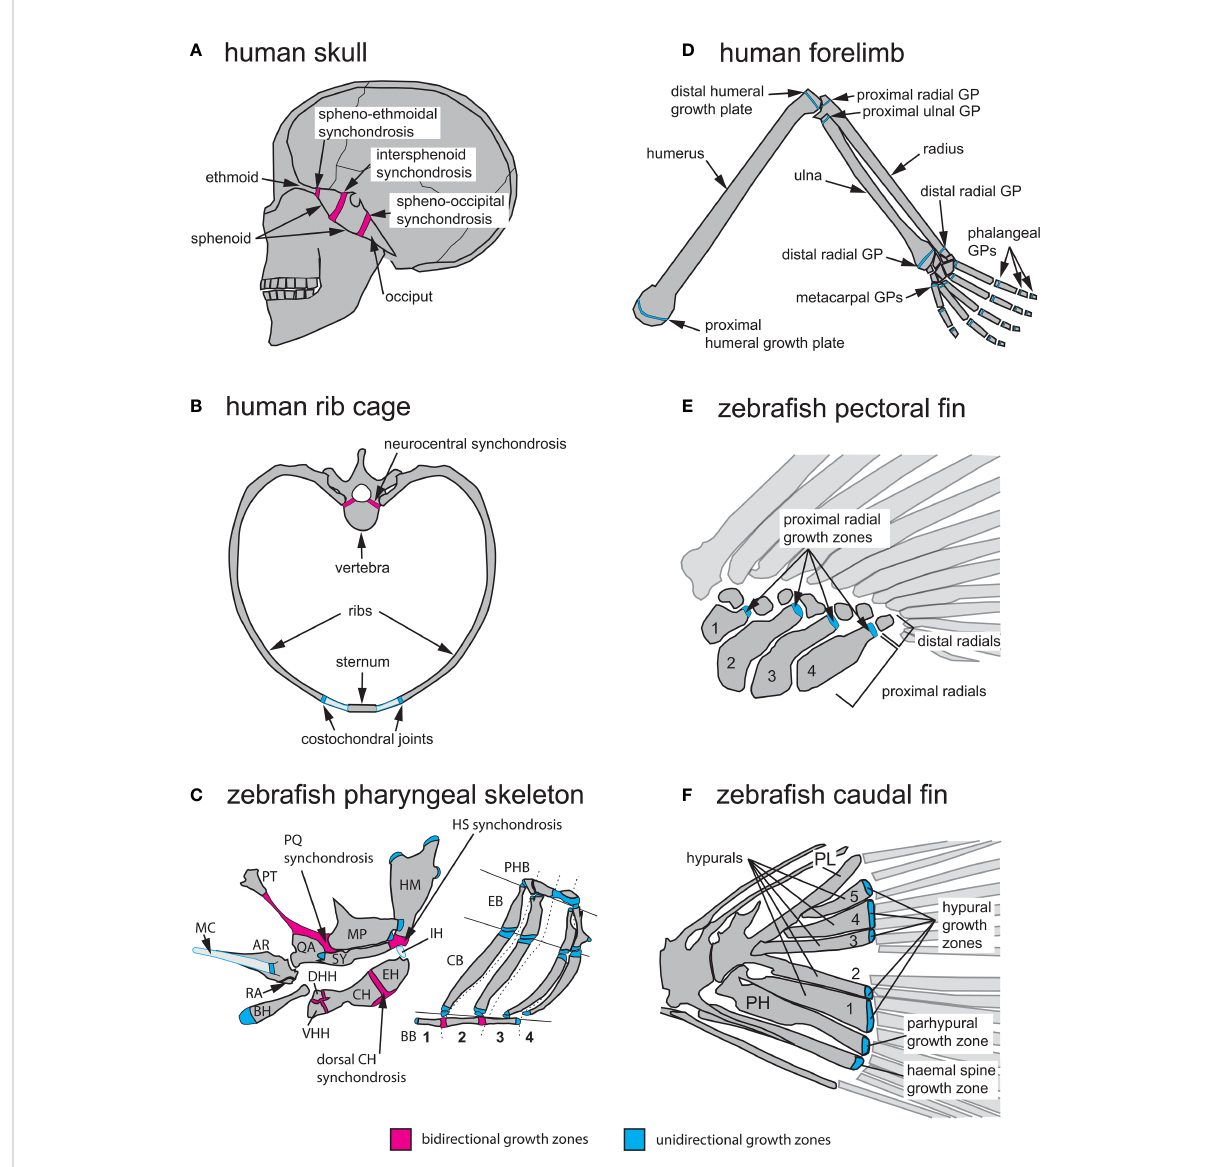
FIGURE 3 Anatomical locations of endochondral growth zones in human vs zebra fi sh. (A) Three synchondroses mediate growth of the human skull base (depicted in sagittal view): the spheno-ethmoidal-, intersphenoid- and spheno-occipital synchondroses. (B) Endochondral growth of human vertebrae and ribs (depicted in transverse view) takes place at neurocentral synchondroses and costochondral joints, respectively. (C) Over thirty endochondral growth zones mediate zebra fi sh pharyngeal skeleton growth. Three highly visible synchondroses mediate growth of fi rst and second pharyngeal arch (PA1-2) skeletons. The PQ synchondrosis mediates growth of the QA and MP. The HS synchondrosis mediates growth of the SY and HM. The dorsal CH synchondrosis mediates growth of the CH and EH. In PA1 and 2, epiphyseal growth zones are found at the posterior MP, anterior SY, dorsal HM and anterior BH. In the gill supporting skeleton, epiphyseal growth zones are found at the ends of each CB and EB bone. (D) Axial growth of human stylopod (humerus, femur) and zeugopod (radius, ulna, tibia, fi bula) bones is mediated by epiphyseal growth zones (=growth plates) located at each bone extremity. A single proximal epiphyseal growth zone mediates axial elongation of each autopod long bone (hand and foot phalanges). (E) In the zebra fi sh pectoral fi n, epiphyseal growth zones are found at the distal end of each proximal radial. (F) In the zebra fi sh caudal fi n, epiphyseal growth zones located at the distal end of each hypural bone (H1-5), the prehypural and two last haemal spines mediate axial elongation. AR, articular; BB, basibranchials; BH, basihyal; CB, ceratobranchial; CH, ceratohyal; DHH, dorsal hypohyal; EB, epibranchial; EH, epihyal; HM, hyomandibular; HS, hyosymplectic; IH, interhyal; MC, Meckel ’ s cartilage; MP, metapterygoid; PH, parhypural; PHB, pharyngobranchials; PL, pleurostyle; PT, palatine; QA, quadrate; RA, retroarticular; SY, symplectic; VHH, ventral hypohyal. Red indicates bidirectional- and blue indicates unidirectional growth